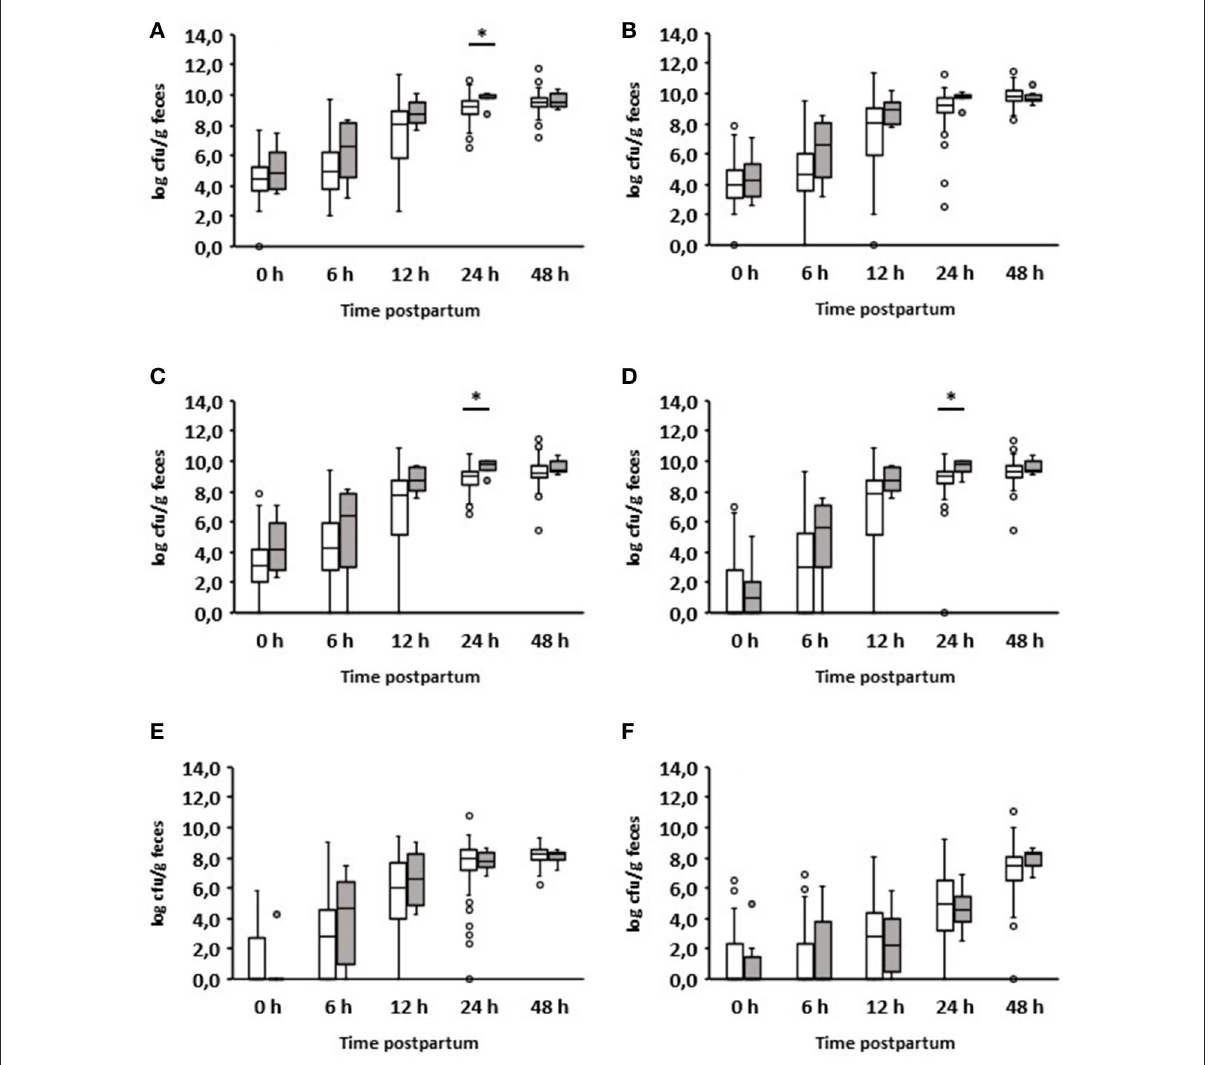
FIGURE2 Fecal microbial contents of selected bacterial groups of healthy calves (white boxes, n = 144) and calves with diarrhea within 24h after birth (gray boxes, n = 6). (A) Aerobic bacteria; (B) anaerobic bacteria; (C) Enterobacteriaceae ; (D) E. coli ; (E) Enterococcus spp.; (F) Lactobacillus spp. (Wilcoxon test, * p <